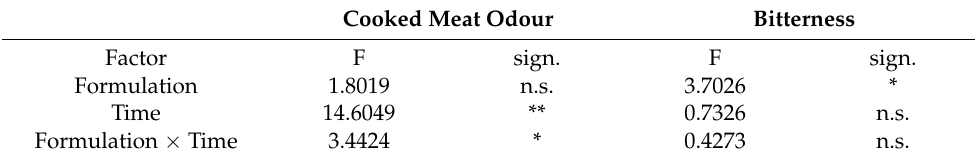
Table 6. Anova matrix results for significant descriptors (cooked meat odour and bitterness). Cooked Meat Odour Bitterness Factor F sign. F sign. Formulation 1.8019 n.s. 3.7026 * Time 14.6049 ** 0.7326 n.s. Formulation × Time 3.4424 * 0.4273